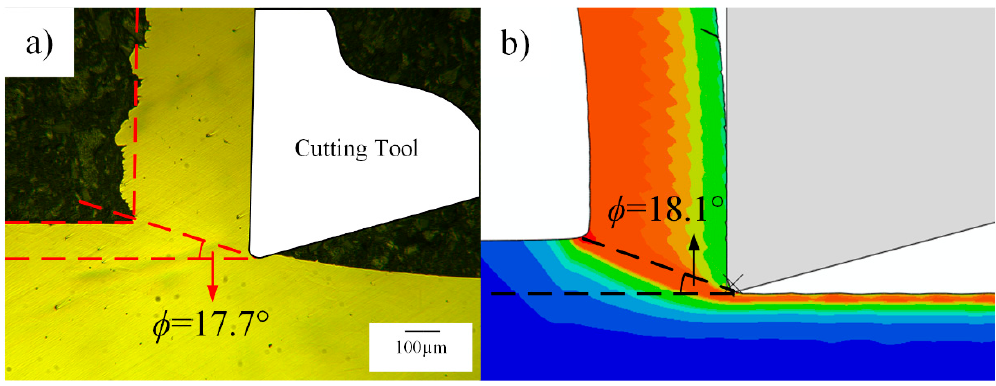
Figure 8. Shear angle measured from ( a ) experimental results and ( b ) simulation results.